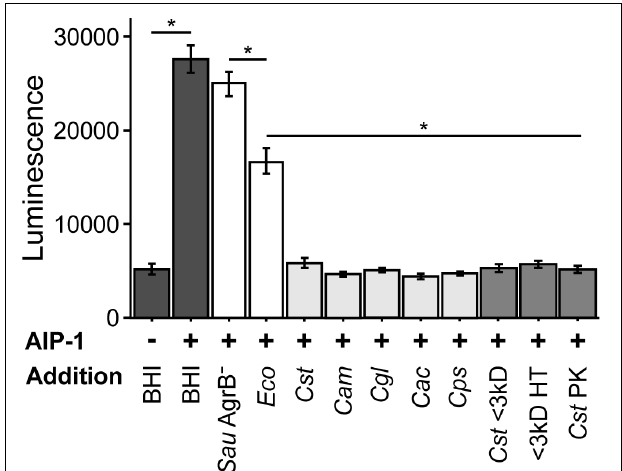
activity assay, we tested the ability of CFCM from the indicated species to inhibit activation of agrP3 after exposure to exogenous AIP-1. Dark gray bars indicate AIP-1 negative and positive controls. White bars indicate CFCM controls from S. aureus JE2 containing a Tn insertion in agrB and the plasmid-free derivative of the E. coli strain used to exogenously produce AIP-1. Light gray bars indicate CFCM from 48 h cultures of C. striatum , C. amycolatum , C. glutamicum , C. accolens, and C. pseudodiphtheriticum , respectively. Medium gray bars indicate C. striatum ( Cst ) CFCM treatments, ‘ < 3 kD’ indicates sub 3 kilodalton fractions, ‘HT’ is CFCM heat treated at 95 ◦ C for 15 m, ‘PK’ indicates Proteinase K digested CFCM. For each bar, n = 3 and error bars represent SEM. For each result between the indicated samples (horizontal line), ∗ p < 0.05 by two-tailed Student’s t -test with Bonferroni correction for multiple